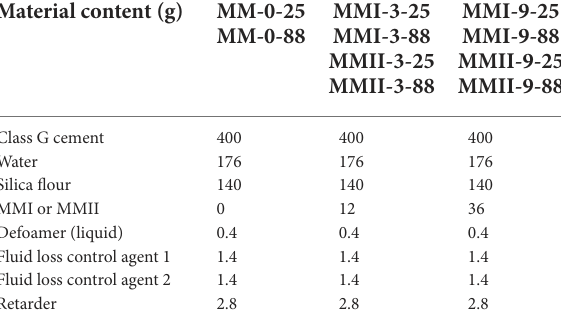
TABLE 2 Formulation of cement slurry samples. Material content